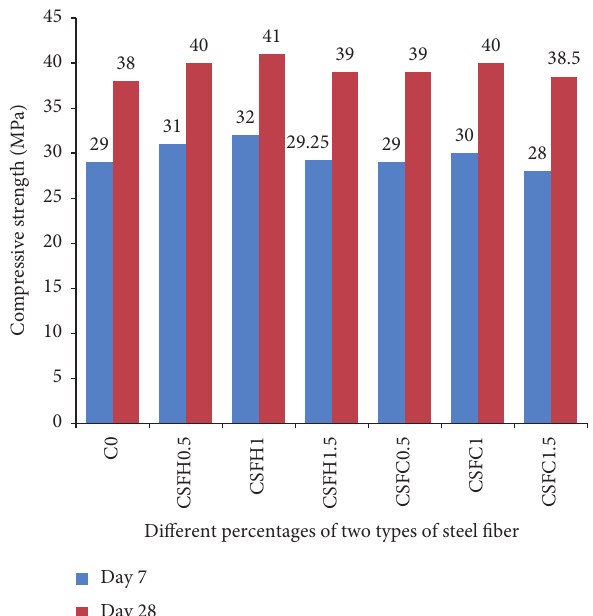
Figure 5: Effect of two types of steel fiber (hooked end and crimped) on compressive